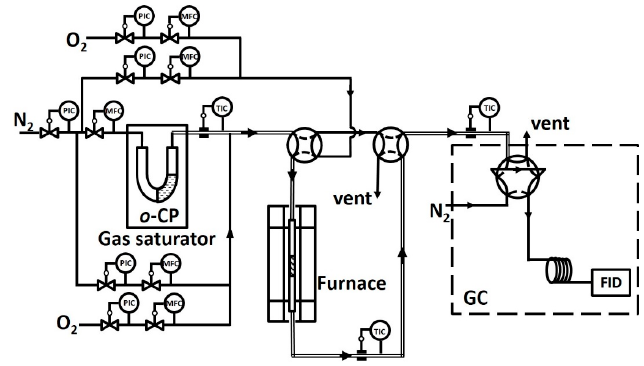
Figure 11. Schematic representation of the experimental setup. Abbreviations: FID, flame ionization detector; PIC, pressure indicator controller; TIC, temperature indicator controller; MFC, mass flow controller.